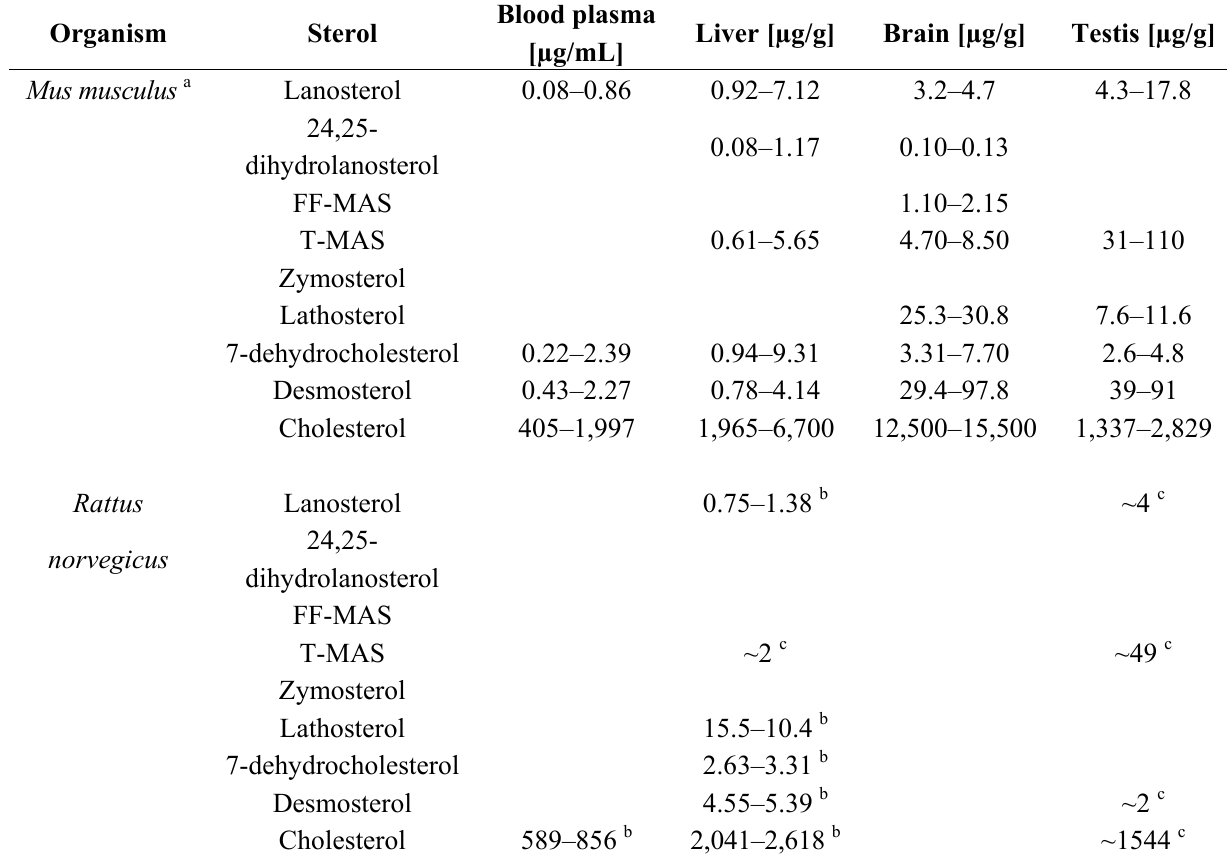
Table 5. Total sterol concentrations (free + esterified) in various tissues of rats and